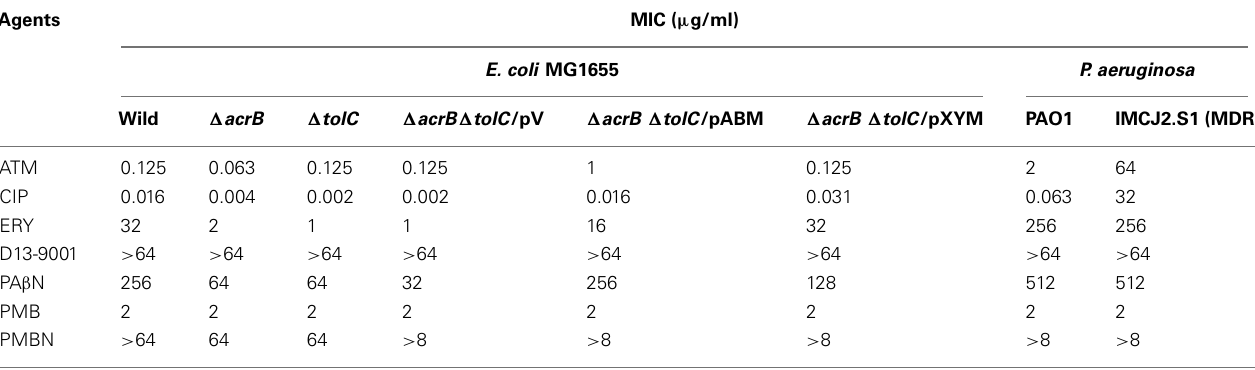
Table 1 | Minimum inhibitory concentrations of agents against tested